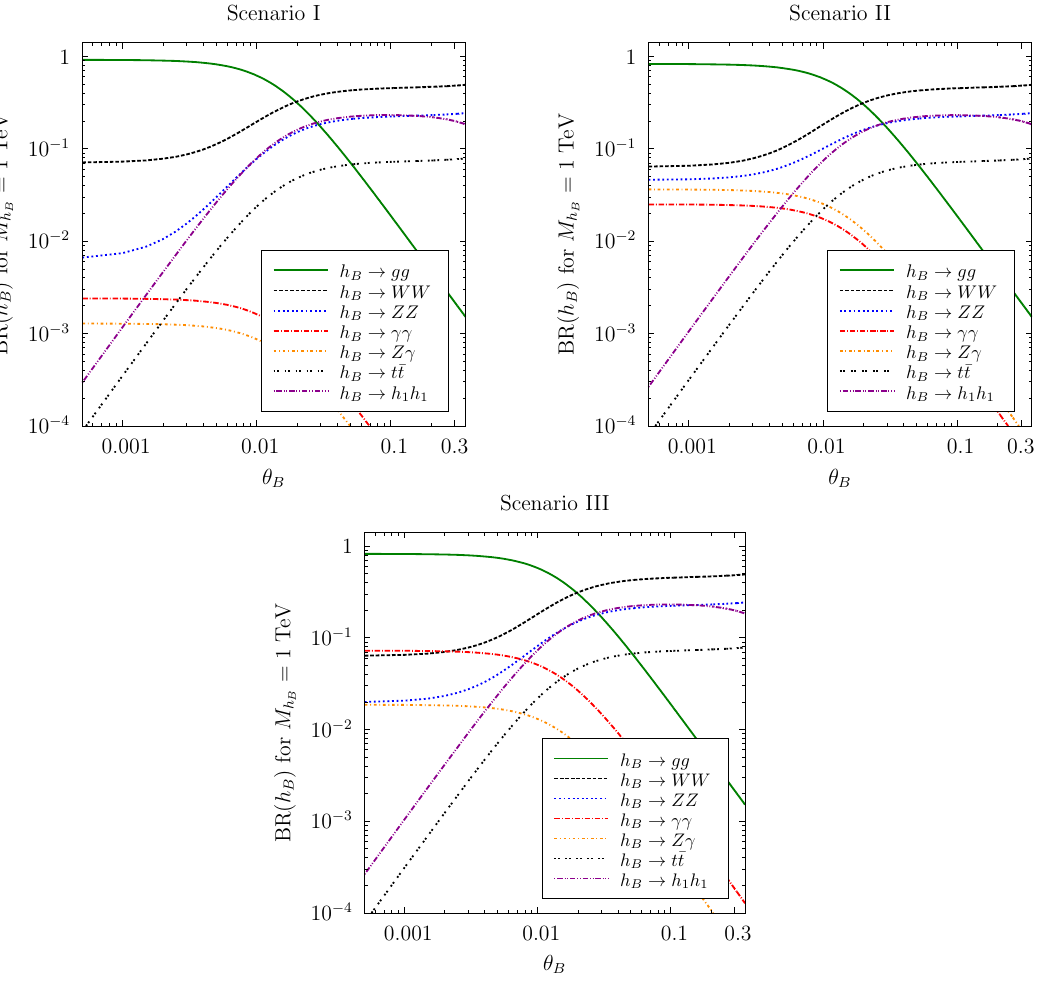
Figure 1 . Branching ratios of the baryonic Higgs as a function of the mixing angle (cid:18) decays into SM particles. The vector-like quarks are assumed to be heavy and we use v B = 2 TeV and M h = 1 B